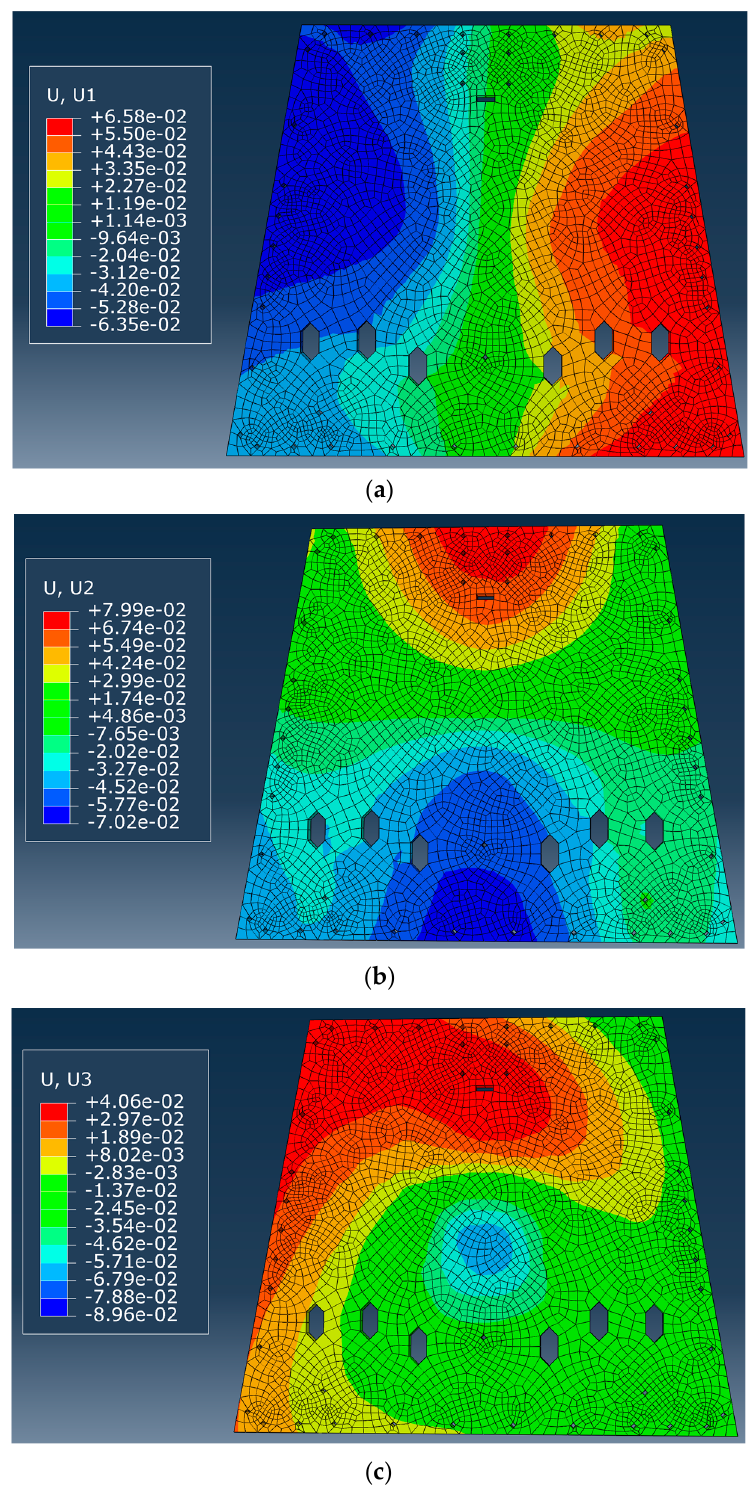
Figure 12. The results of the initial finite element model (unit: mm) ( a ) X-direction ( b ) Y-direction ( c ) Z-direction.